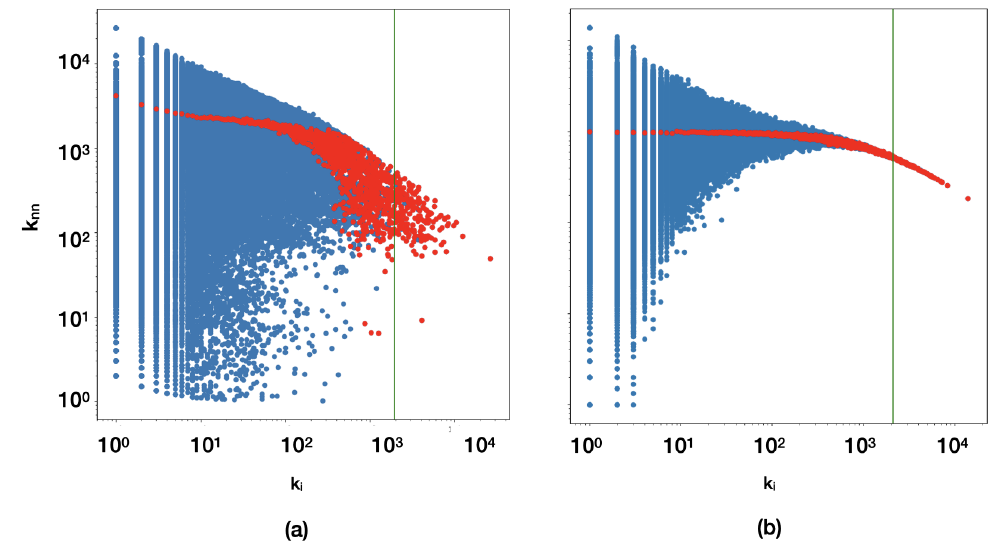
Figure 3. Comparison of the k nn of the retweet (RT) network ( a ) with a configuration model ( b ). The green line corresponds to the structural cutoff value for the degree, while the red dots represent the mean value for each “class” of nodes of degree k . The network displays a slightly disassortative behaviour.